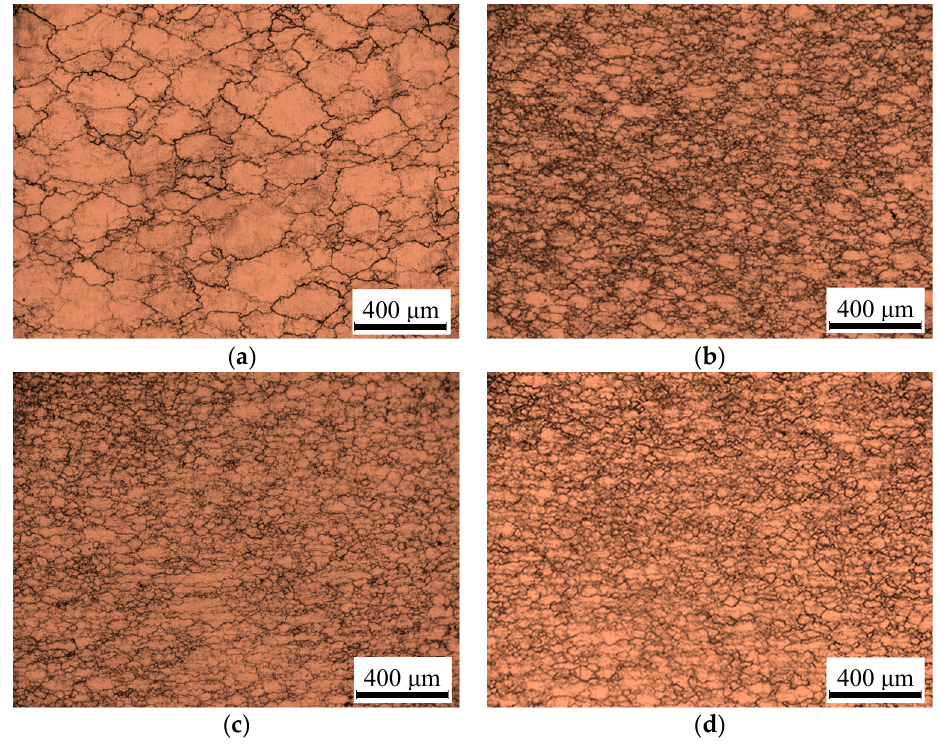
Figure 11. Optical microstructures of the fine-grained alloys deformed at 900 °C/10 − 3 s − 1 and different true strains of ( a ) 0.2, ( b ) 0.4, ( c ) 0.6, and ( d ) 0.8.